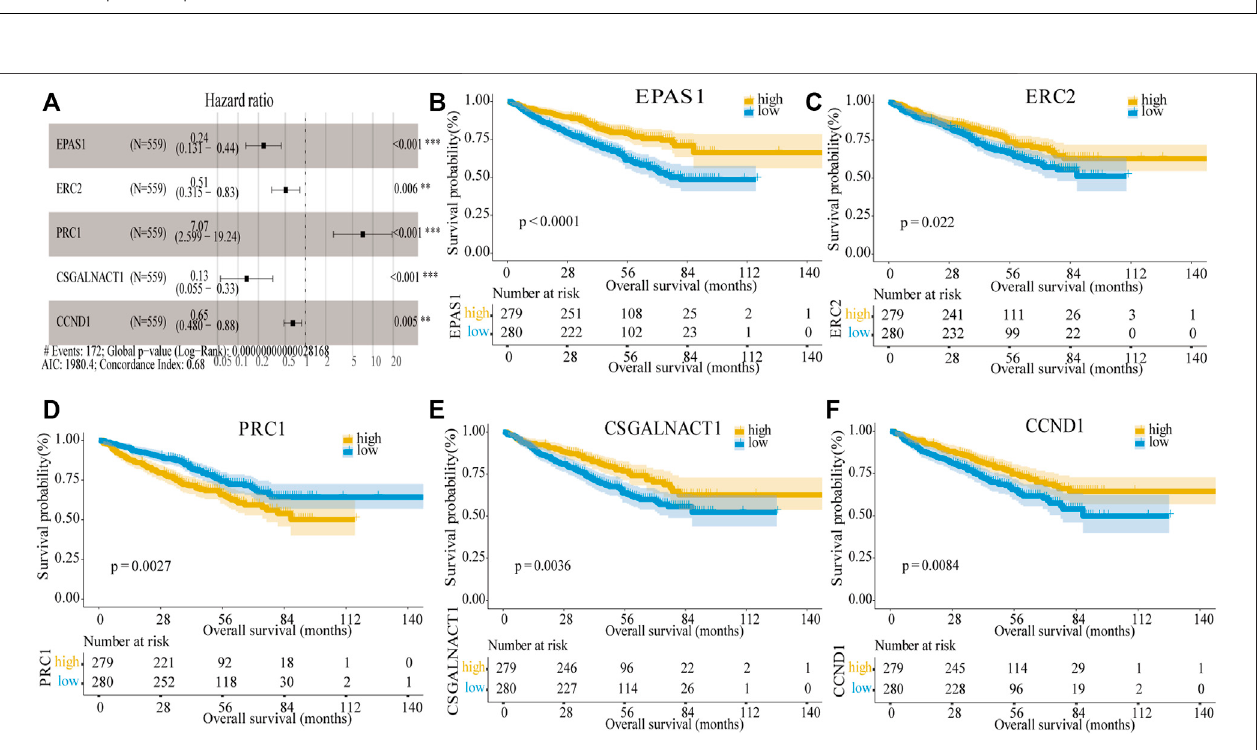
FIGURE 3 | Construction of the fi ve-gene risk score model. (A) Multivariate Cox regression analysis of the fi ve genes (** p < 0.01 and *** p < 0.001). The fi gure also showed Hazard ratio, Global log-rank p, C-index, and AIC. (B – F) Kaplan – Meier survival of fi ve prognostic genes: EPAS1 , ERC2 , PRC1 , CSGALNACT1 , and CCND1 .